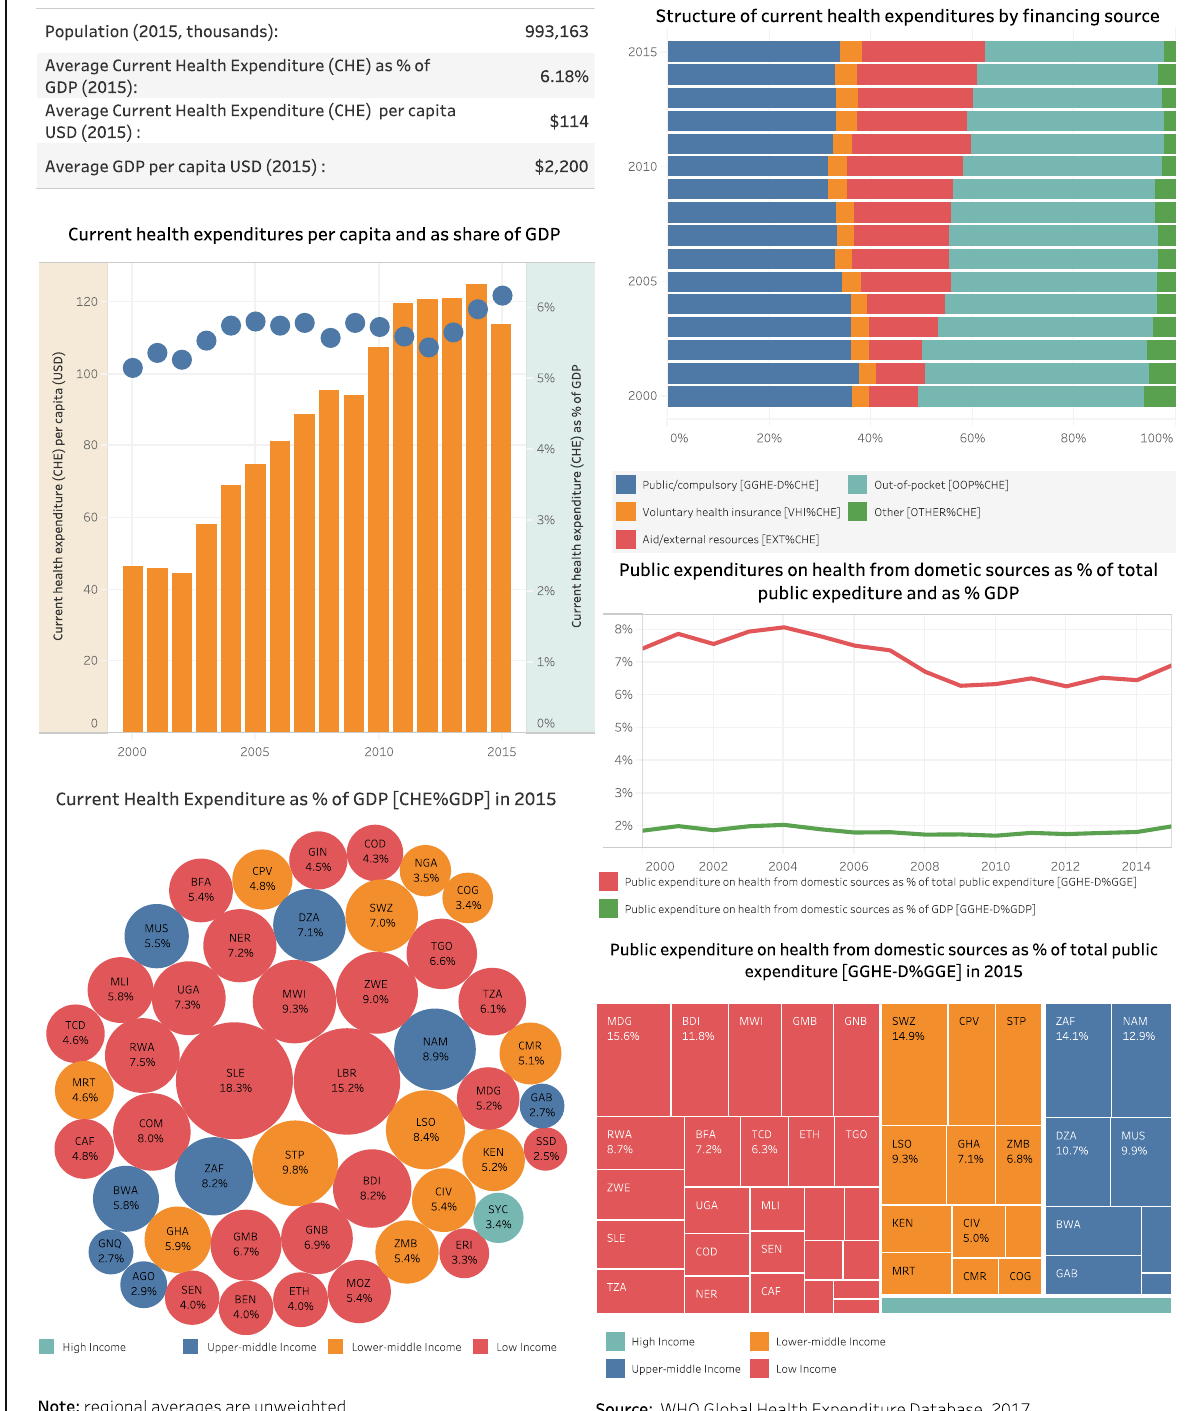
Fig. 4 African Regional Health Expenditure